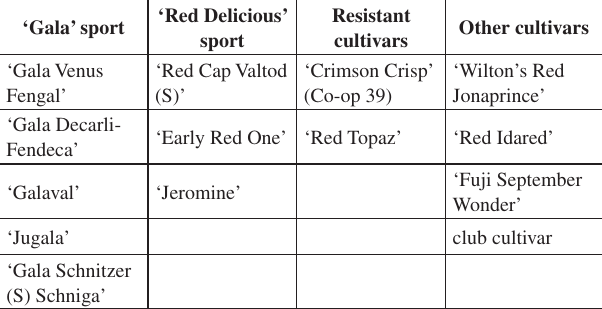
Table 1: The classification of the examined cultivars